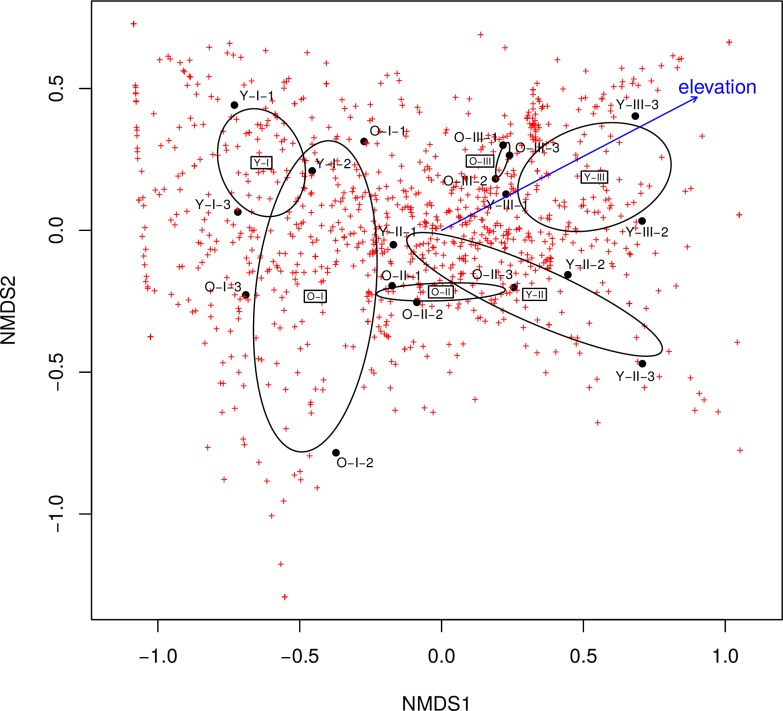
NMDS ordination plot of all sampled sites, based on the composition of fungal taxa (on the level of species, stress = 1.4).All explanatory variables that were found to have a significant influence (p<0.05) are shown as vectors. Each sample is labelled according to the age of the host tree ('O' for old, 'Y' for young individuals), the altitude ('I','II','III', see Fig 1) and the replicate number ('1','2','3'). For the 6 biological replicate groups (Y-I to O-III), ellipses are drawn according to the standard deviation of point scores (function ordiellipse in vegan).